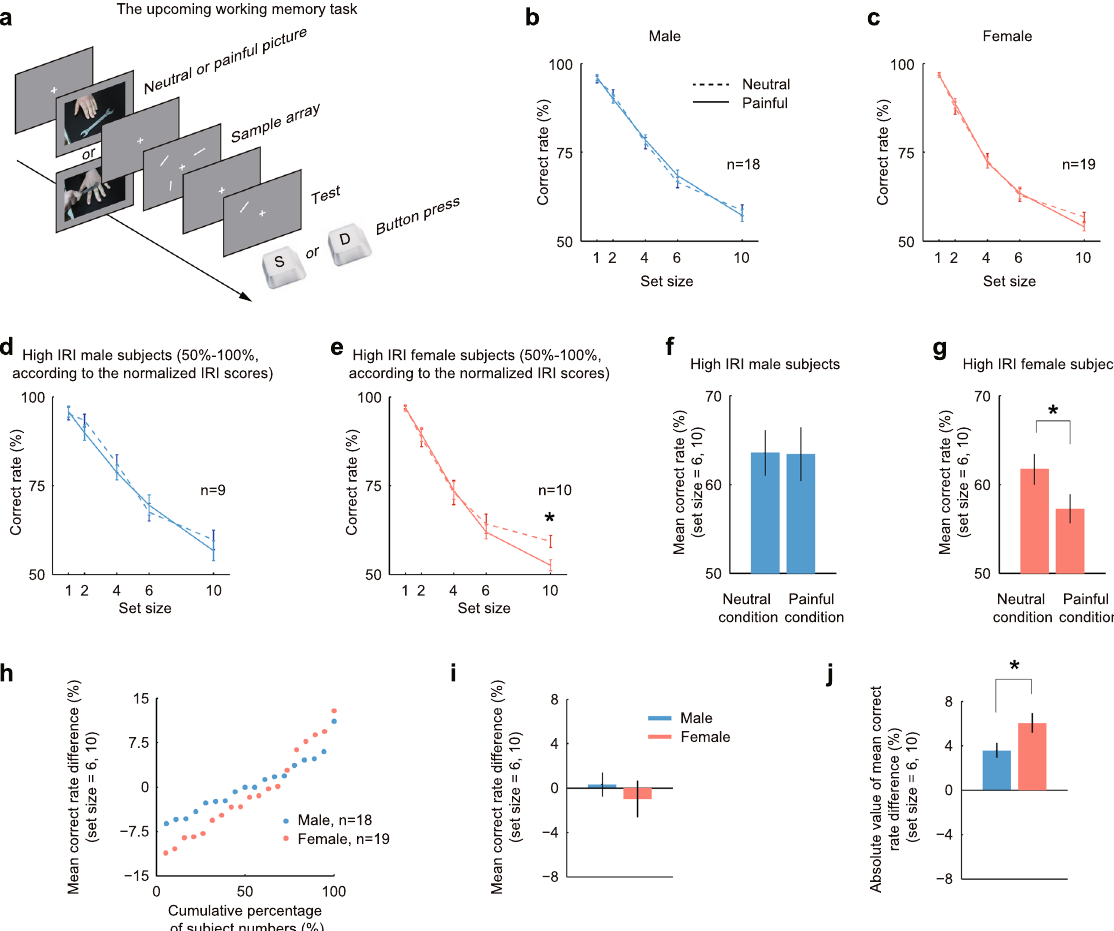
Figure 2. The influences of empathic pain on the upcoming working memory. (a) The upcoming working memory task tested the influences of painful pictures on the working memory of events which would occur in the future. After the fixation point disappeared, either a neutral picture or a painful picture would appear on the screen center randomly. The sample array appeared later which might consist of 1, 2, 4, 6 or 10 bars. After a working memory period, a test bar appeared and the subjects should indicate whether the orientations of the sample and test bars were the same or different by pressing “S” or “D” button accordingly. (b,c) The performances of males (b) and females (c) in upcoming working memory task. The correct rate decreased as the number of items (set size) in the sample array increased. There was no statistical difference between neutral (dashed line) and painful conditions (solid line) for either gender. ( d–g) The performances of high IRI male subjects (d,f) and high IRI female subjects (e,g) . Subjects were arranged by their IRI scores from small to large, and high IRI subjects referred to the first 50% subjects. While the number of items was large (set size = 6, 10), the correct rates of females (e) , but not those of males (d) , were impaired by empathic pain. For males, the mean correct rate of large set sizes (set size = 6, 10) did not differ between the neutral and painful conditions ( f ). For females, the mean correct rate of large set sizes (set size = 6, 10) under painful condition decreased 7.3%, compared with neutral condition ( g , F(1, 44) = 4.4788, P = 0.04, two-way ANOVA). (h–j) The mean correct rate differences between neutral and painful conditions (neutral minus painful) at large set sizes distributed differently between genders. The females exhibited relatively more dispersed distribution (h) . The averaged mean correct rate difference did not differ much between males and females ( i ), but the absolute value of mean correct rate difference of females was significantly higher than that of males ( j , P = 0.0314, d.f. = 35, t -test, d =